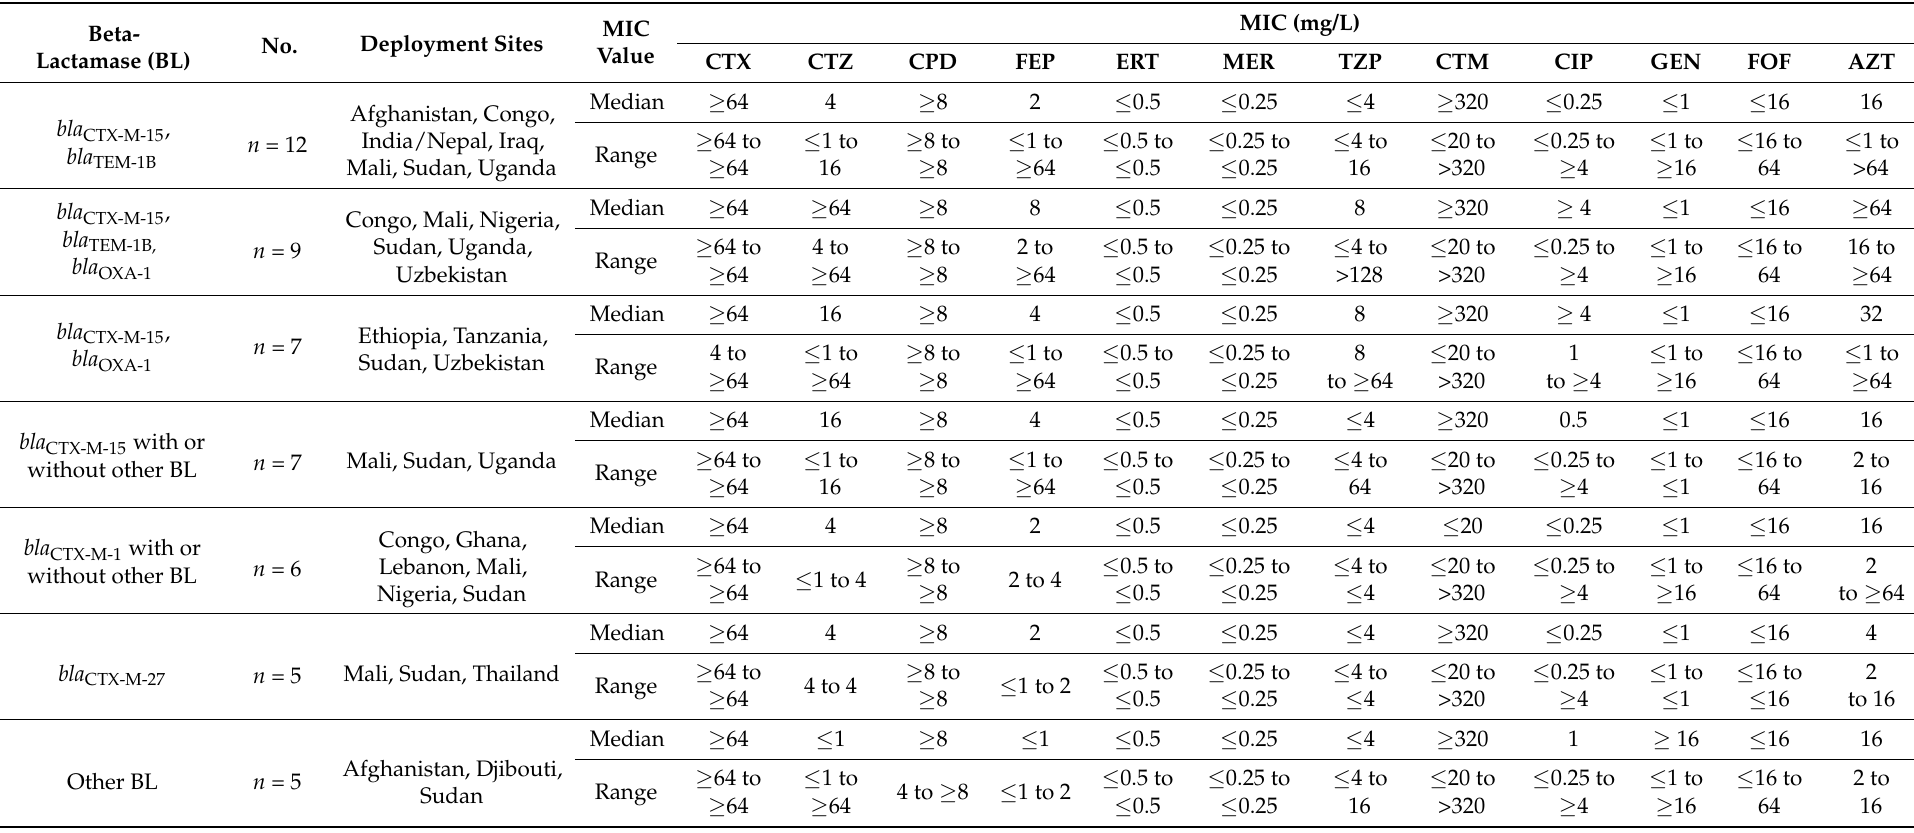
Table 1. Antimicrobial susceptibility of all isolates stratified by beta-lactamase detection and deployment